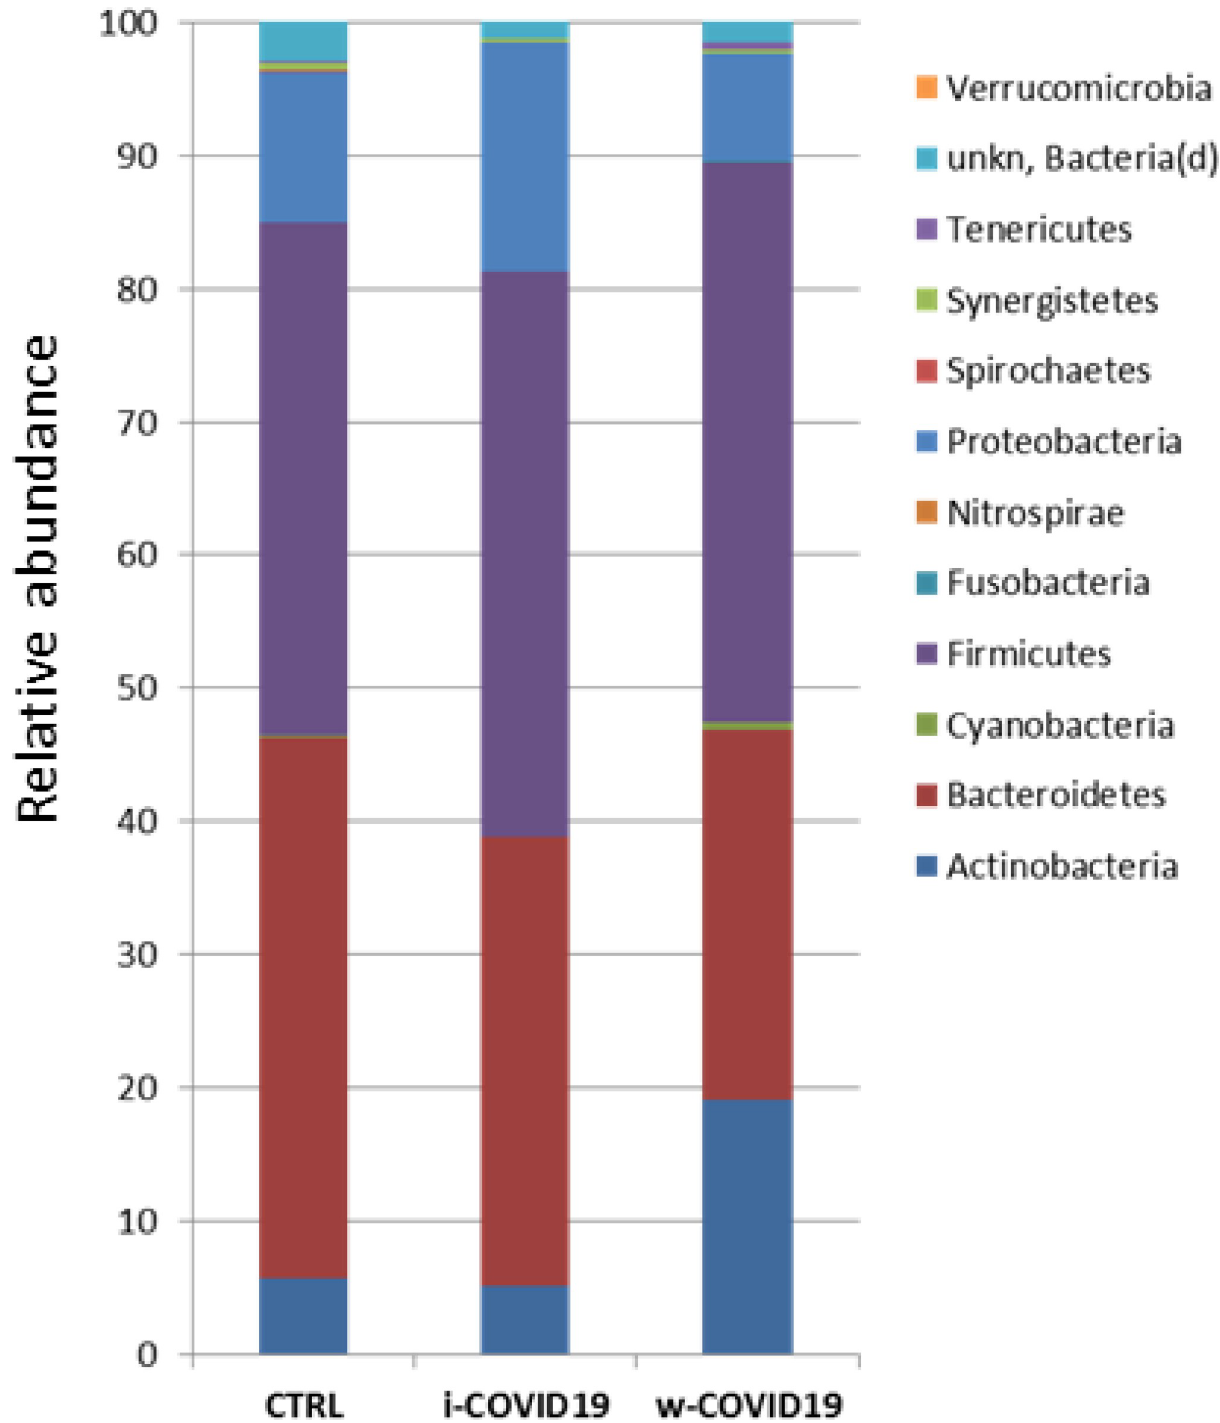
Fig 3. Microbiota composition of w-COVID19, i-COVID19 patients and CTRL, at the phylum level. The mean value of all the detected taxa is represented.